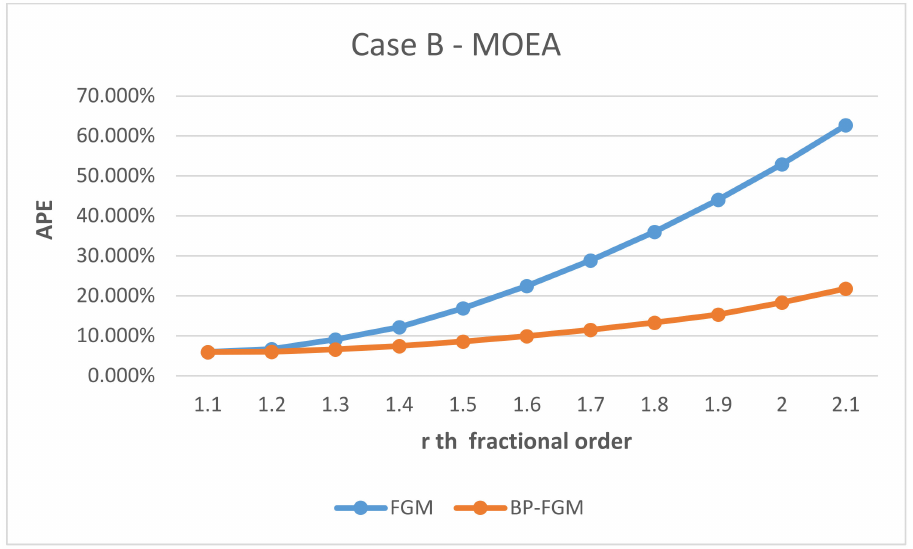
Figure 8. Representing the absolute percentage error for Case B by using the FGM and BP-FGM